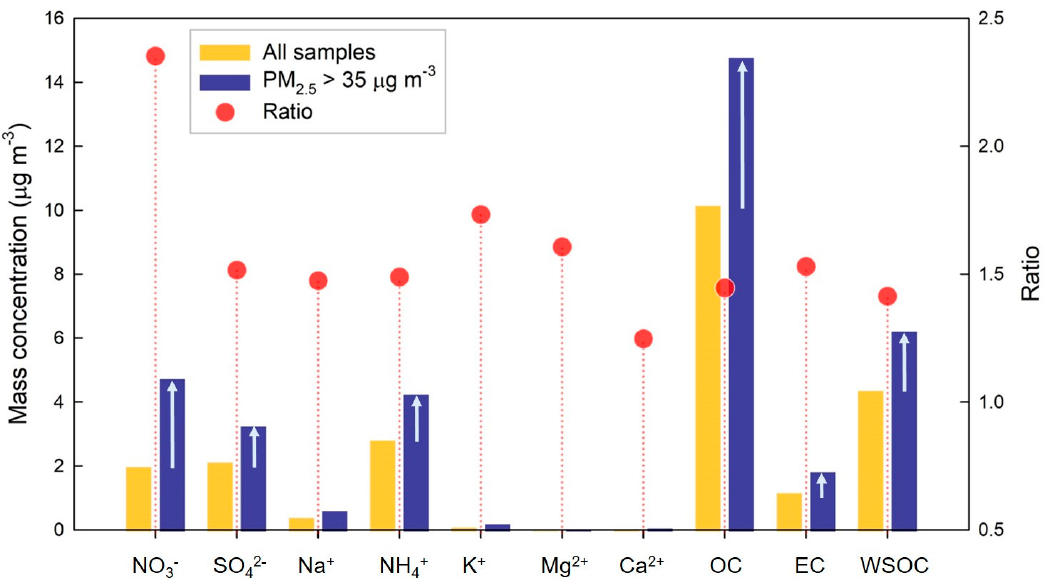
Figure 7. Comparison between the PM 2.5 components of the HCE and non-HCE samples. The red symbols indicate the increment ratio of each PM 2.5 component during the HCE.